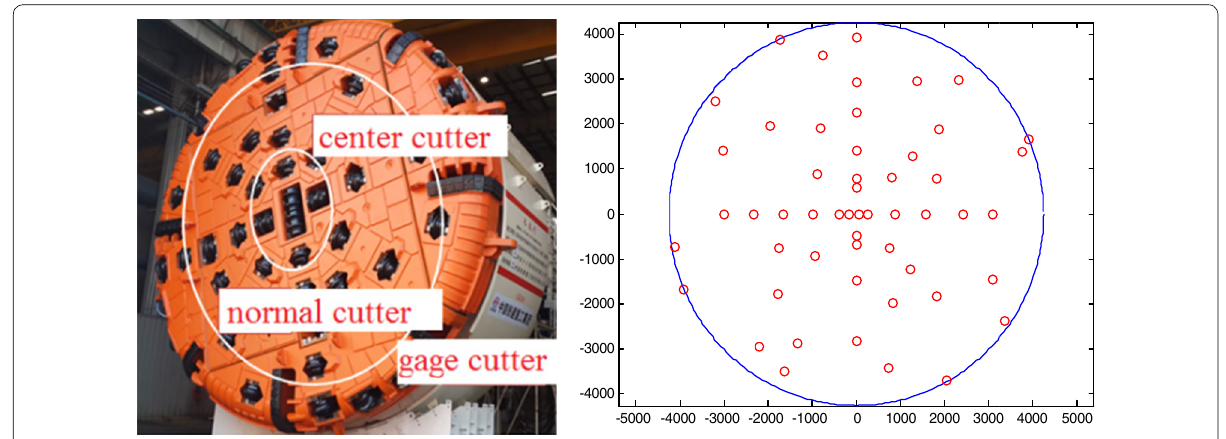
Figure 4 Layout of the disc